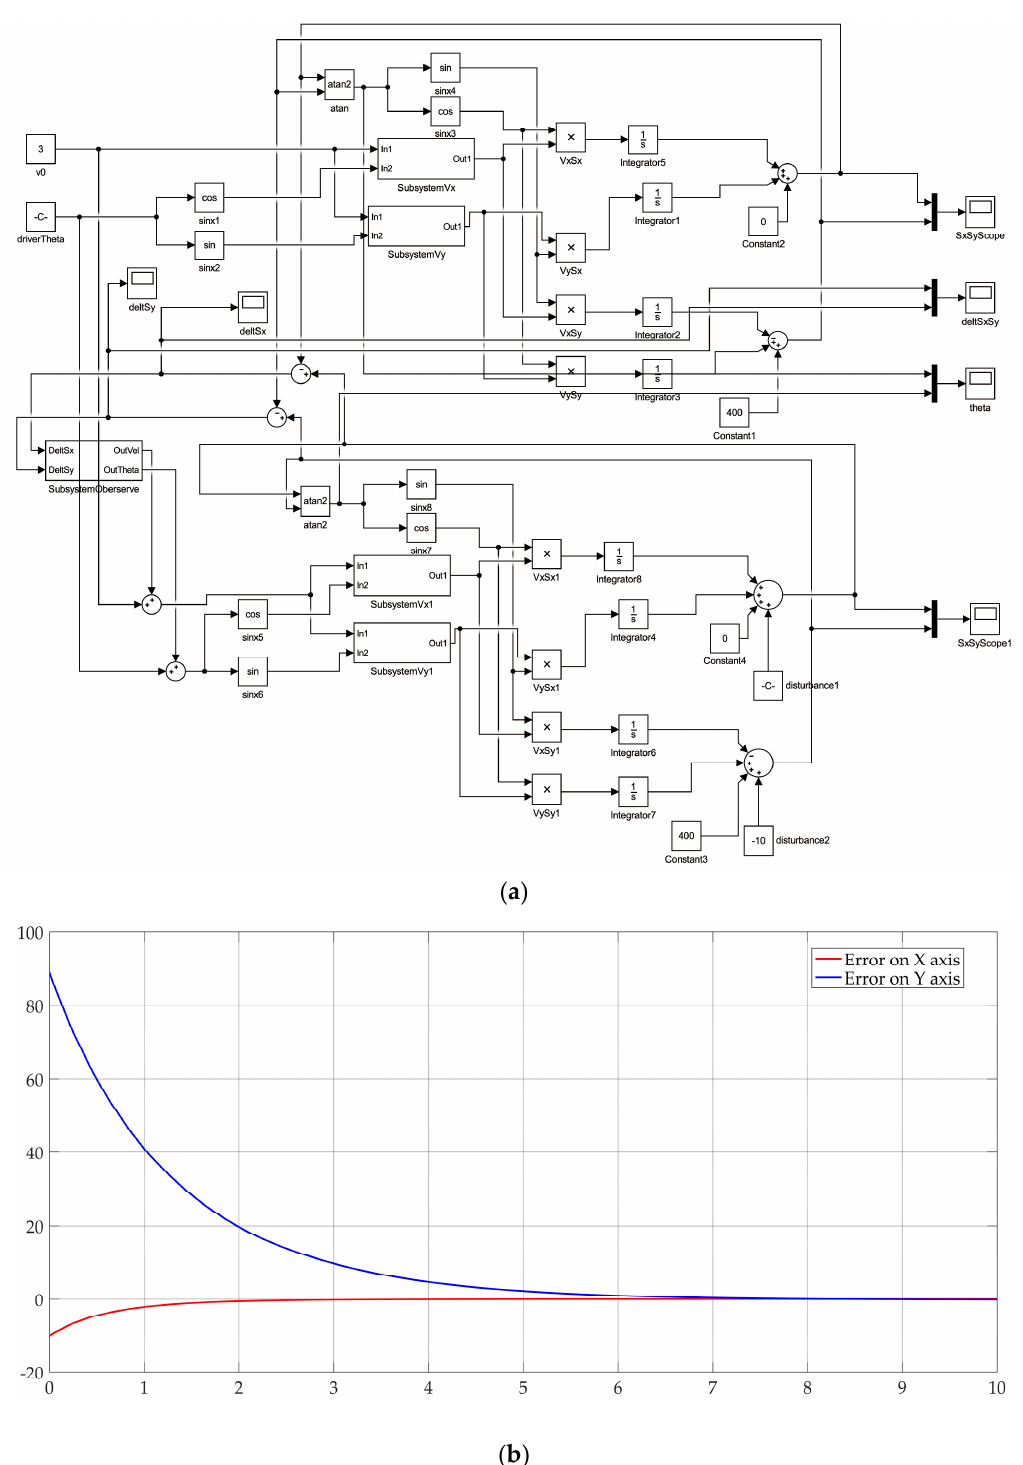
Figure 8. The simulation in Simulink and convergence of results for zero-radius turn. ( a ) Simulink simulative model graph; ( b ) The model reaches a steady convergent state.